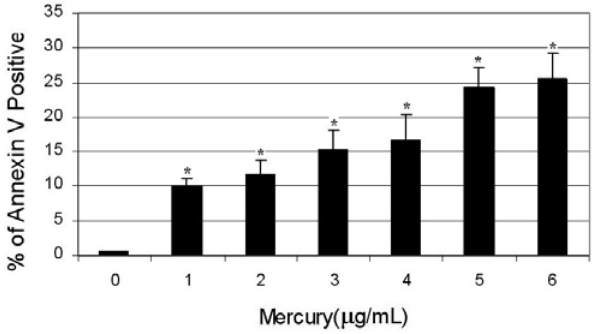
Figure 3: Percentage of Annexin Positive cells with respect to mercury